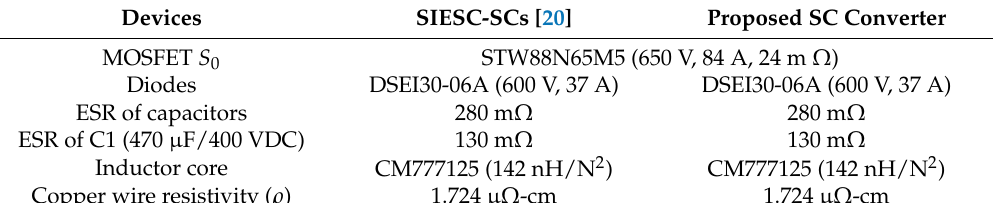
Table 2. Parameters of the devices.